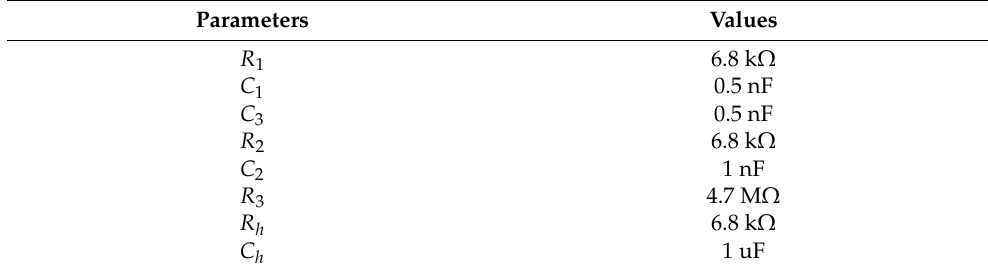
Table 3. Lumped parameter of coil.